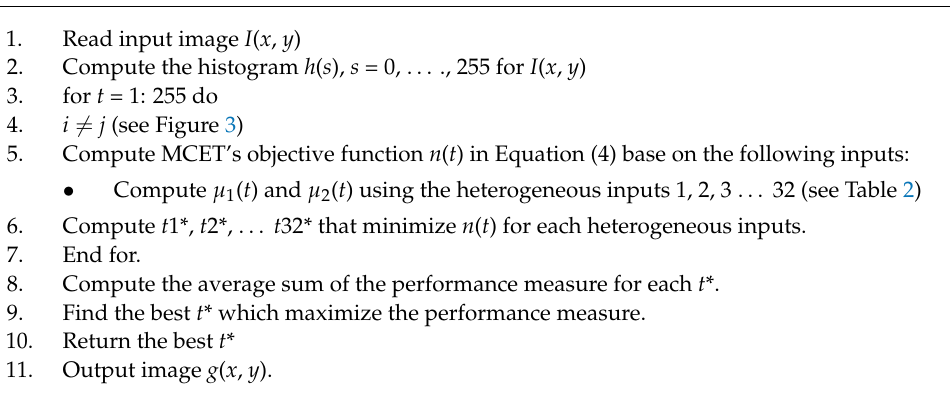
Algorithm 2 Multiple Input-Parallel